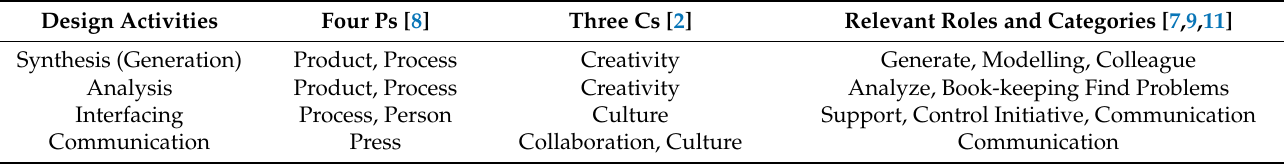
Table 3. Different design activities and their relationships with the Four Ps, Three Cs, and key categorizations of computa- tional creativity. Design